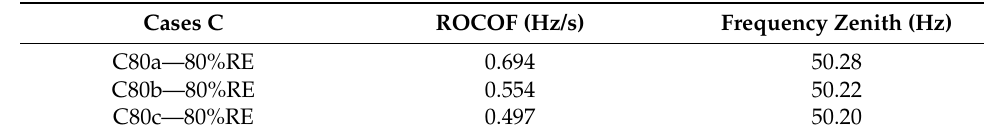
Table 8. ROCOF and frequency zenith for Group C.